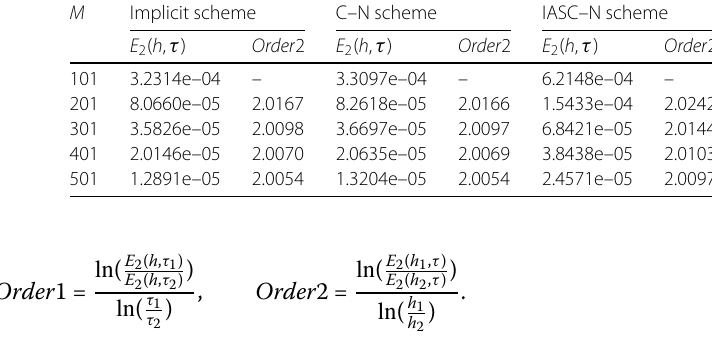
Table 3 Scheme errors and spatial convergence orders ( α = 0.5, τ = h 2 )